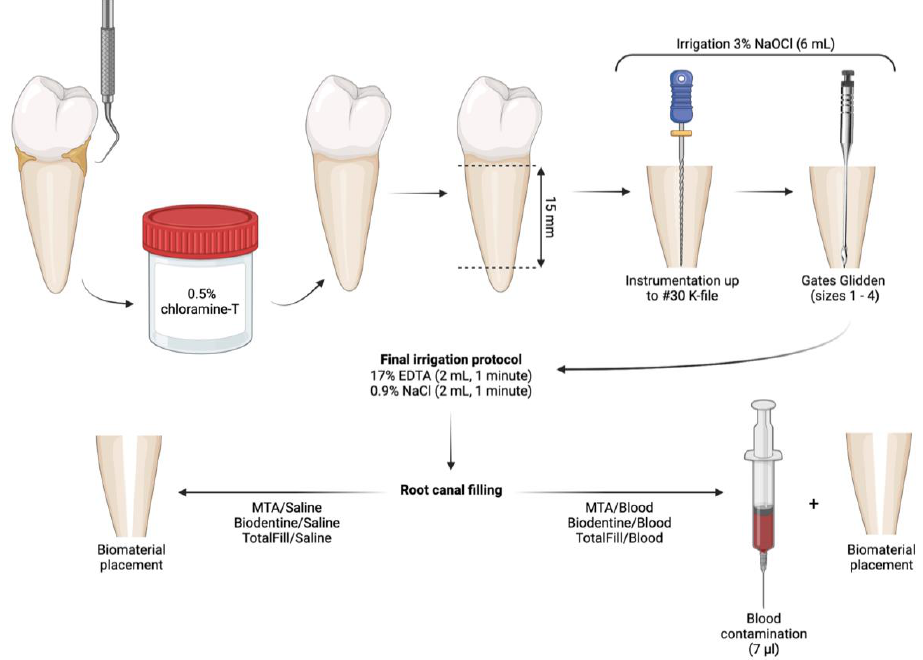
Figure 1. Experimental protocol schematic representation. Created with BioRender.com.